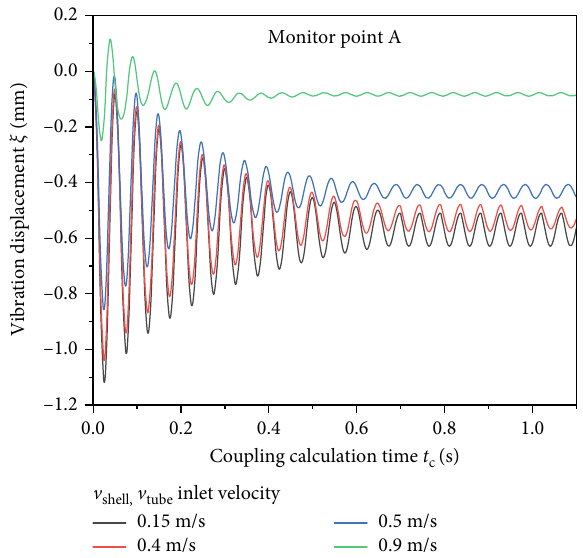
Figure 8: The vibration displacement of monitor point